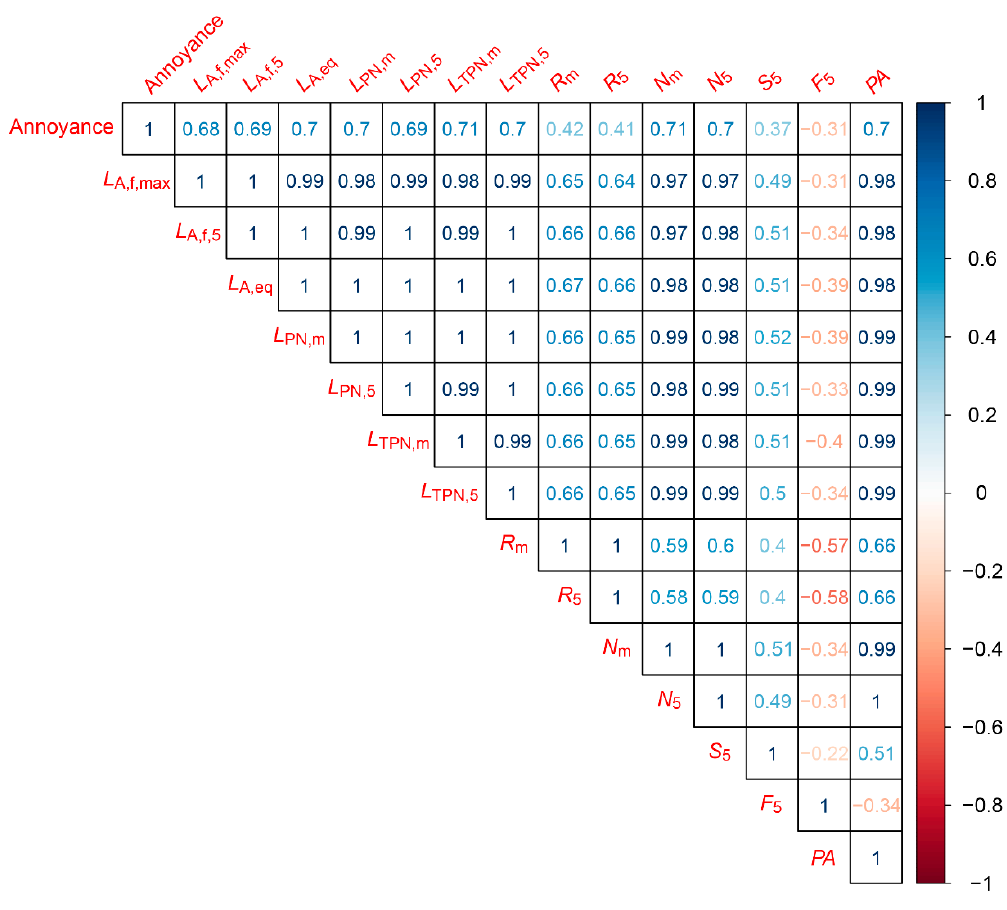
Figure 11. Correlation matrix between annoyance ratings and objective measurements for hover noise events.